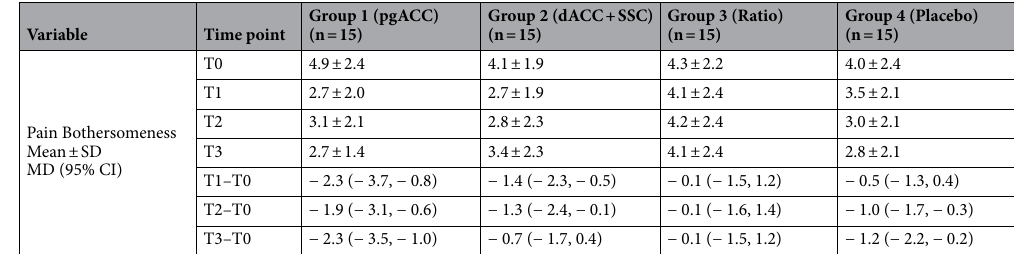
Table 3. Descriptive data for the secondary measures at all timepoints. CI confidence interval, CPM conditioned pain modulation, dACC dorsal anterior cingulate cortex, MD mean difference, MTS mechanical temporalsummation, pgACC pregenual anterior cingulate cortex, PPT pressure pain threshold, SSC somatosensory cortex, SD standard deviation, T0 baseline, T1 immediately post-treatment, T2 1 week follow up, T3 1 month follow up.